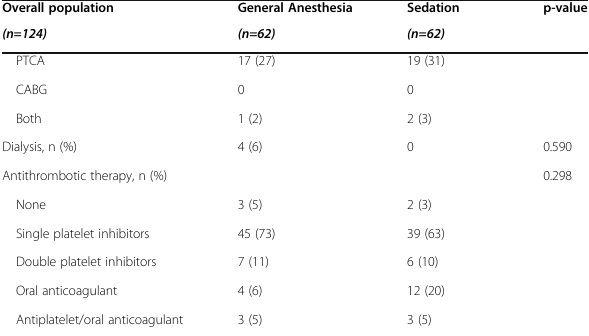
Table 1 (abstract A73). Baseline clinical characteristics (Continued) Overall population